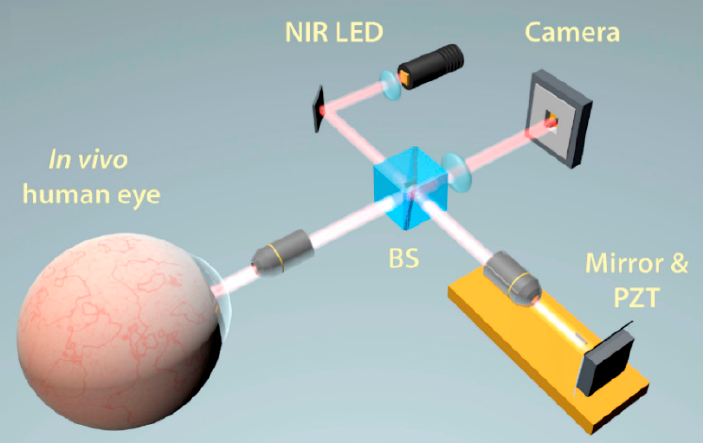
Figure 18. Schematic diagram of a full field OCT (FF-OCT) system [172].